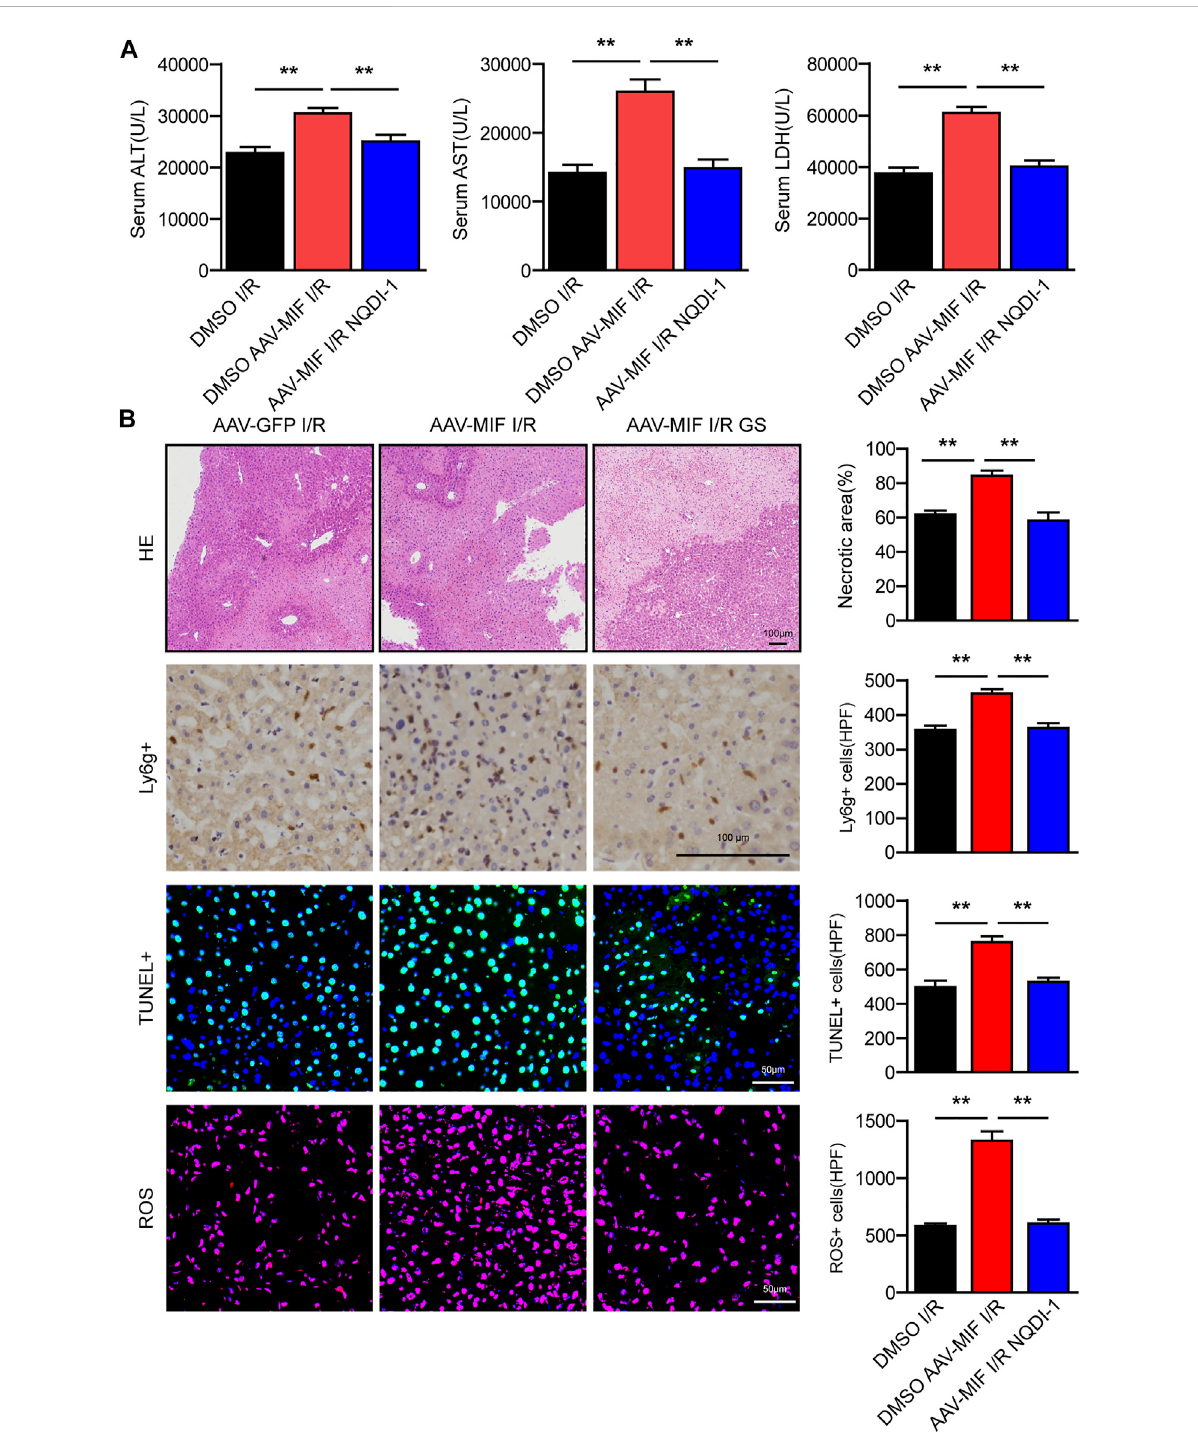
FIGURE 8 The protective effect of MIFde fi ciency inhepatic I/R injury dependson thesuppressionofASK1. (A) SerumALT/AST/LDHactivitiesinmice after hepatic I/R surgery ( n = 6/group). (B) Representative histological HE-stained images, Ly6g positive IHC stained images, TUNEL stained images, DHE stainedimagesand statistical analysis inlivertissue ofmiceafter hepaticI/R surgery( n =4 – 6/group). Scalebar, 100 μ m.Alldata arepresented asthe mean ± SD. Levels of statistical signi fi cance are indicated as** p < 0.01. For statistical analysis, one-way ANOVA with Bonferroni ’ s post hoc analysis or Tamhane ’ s T2 post hoc